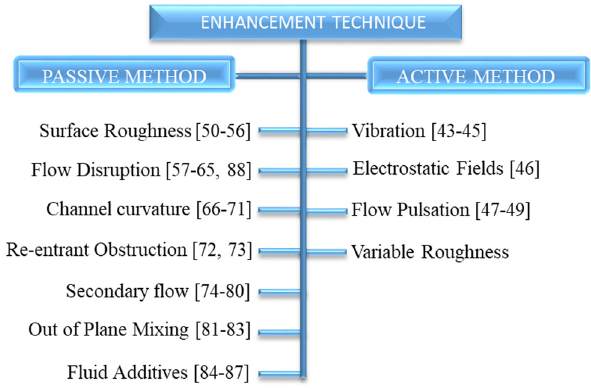
microchannels. Figure 1: Enhancement technique for